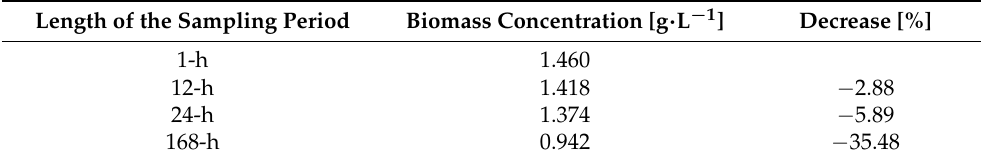
Table 2. Influence of the sampling period on the concentration of